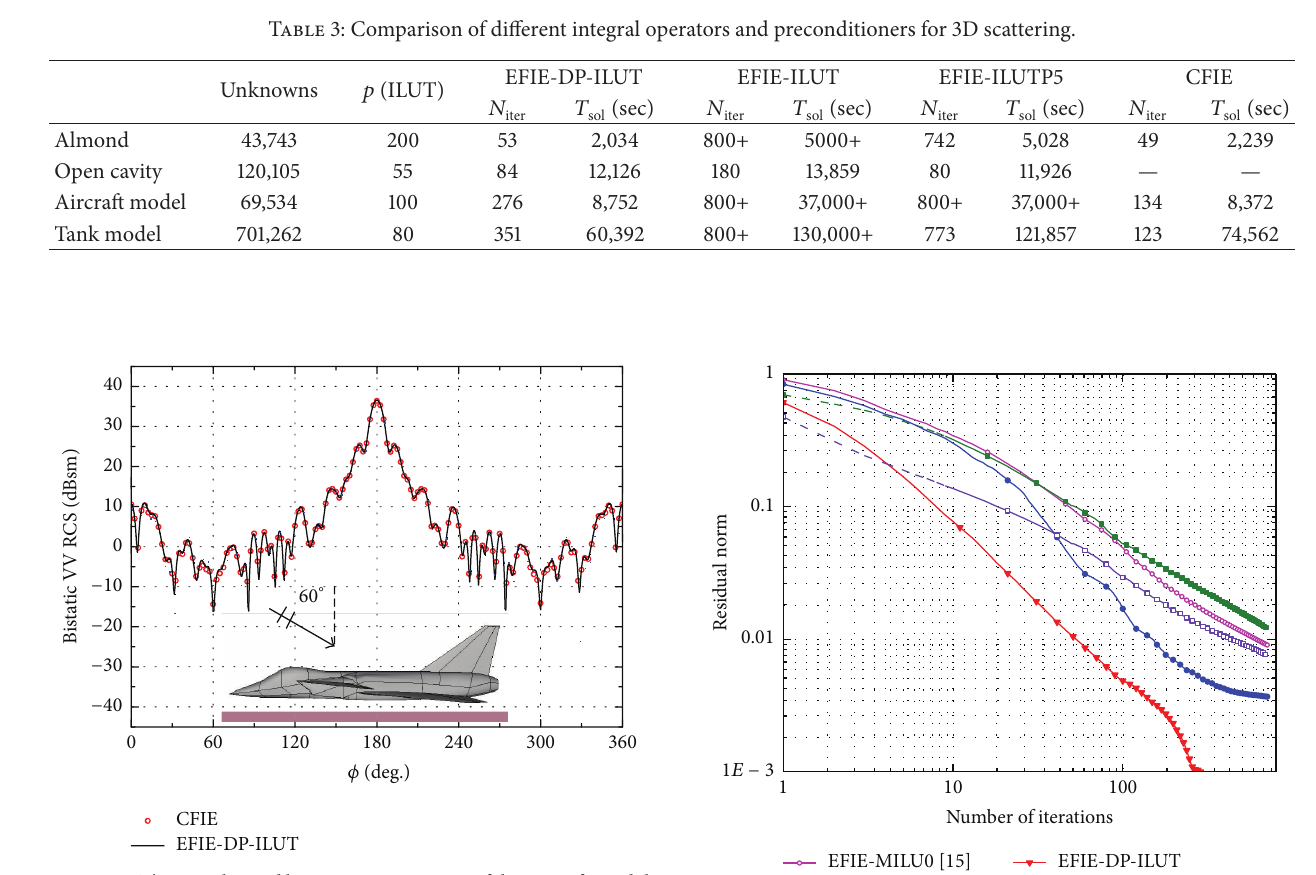
Figure6:TheV-polarizedbistaticRCSpatternsoftheaircraftmodel above the half space in the 𝜃 = 80 ∘ cut at 400 MHz with EFIE-DP- ILUT and CFIE.